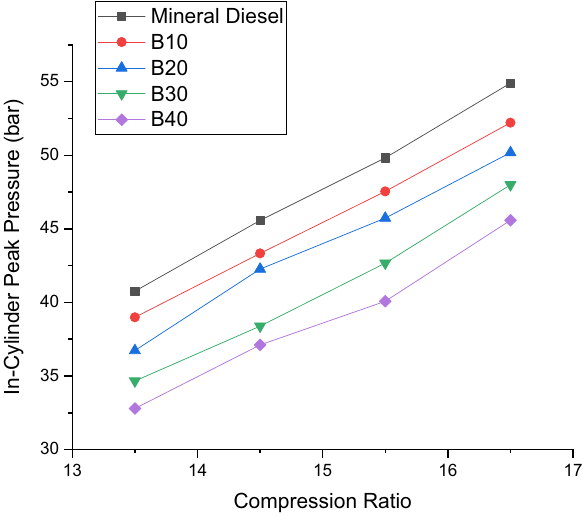
Fig. 6 Variation of ME of dual biodiesel sample blends at different compression ratios